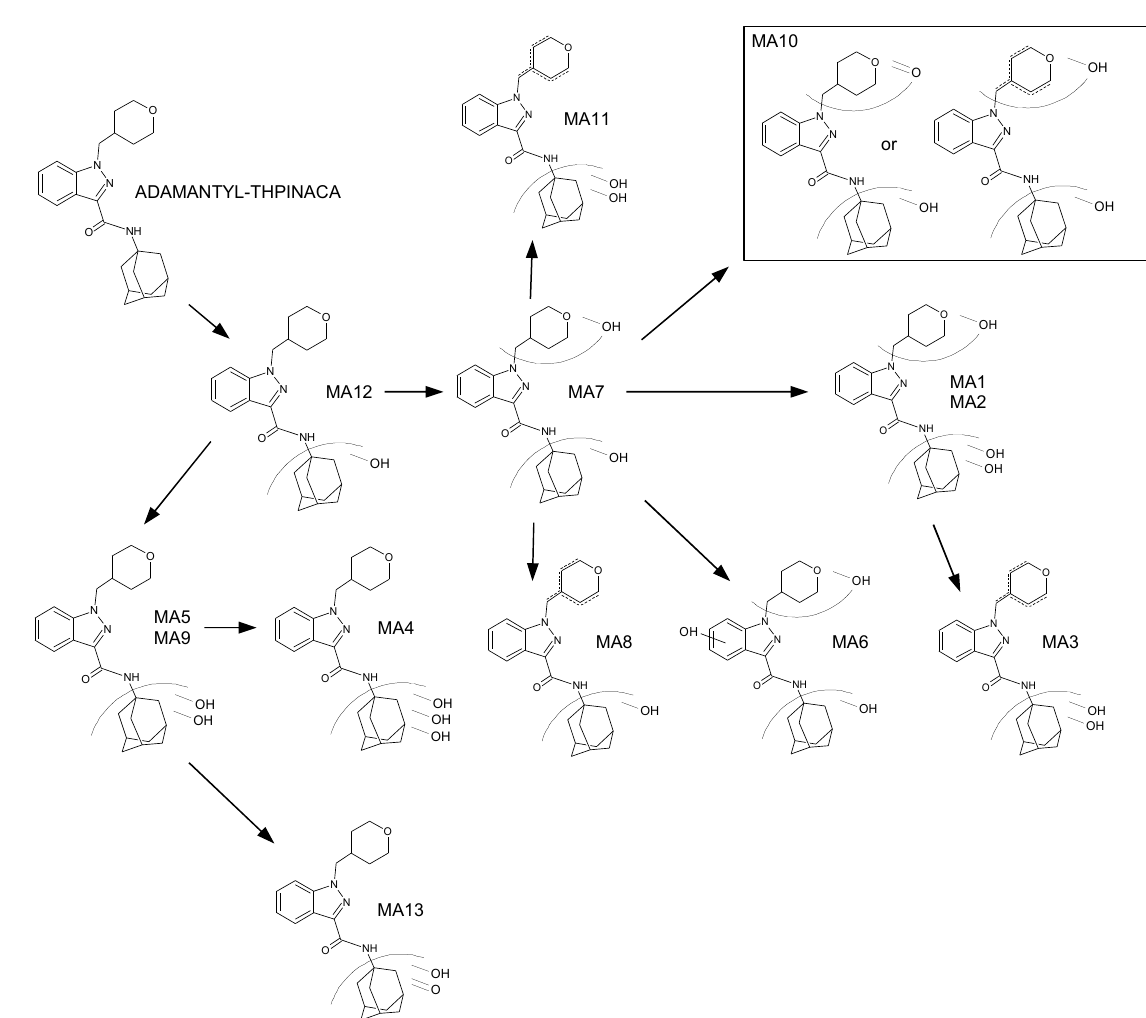
Figure 5. Proposed metabolic pathway of ADAMANTYL-THPINACA.